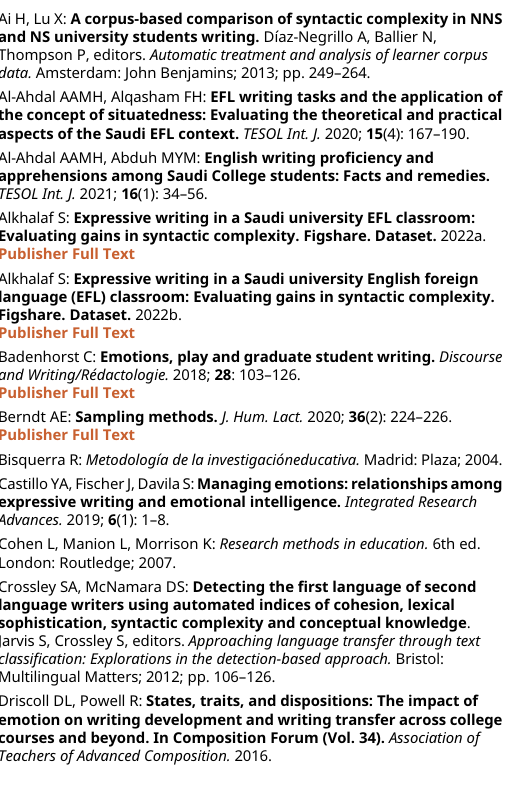
Figshare. Expressive Writing in a Saudi university EFL classroom: Evaluating gains in syntactic complexity.